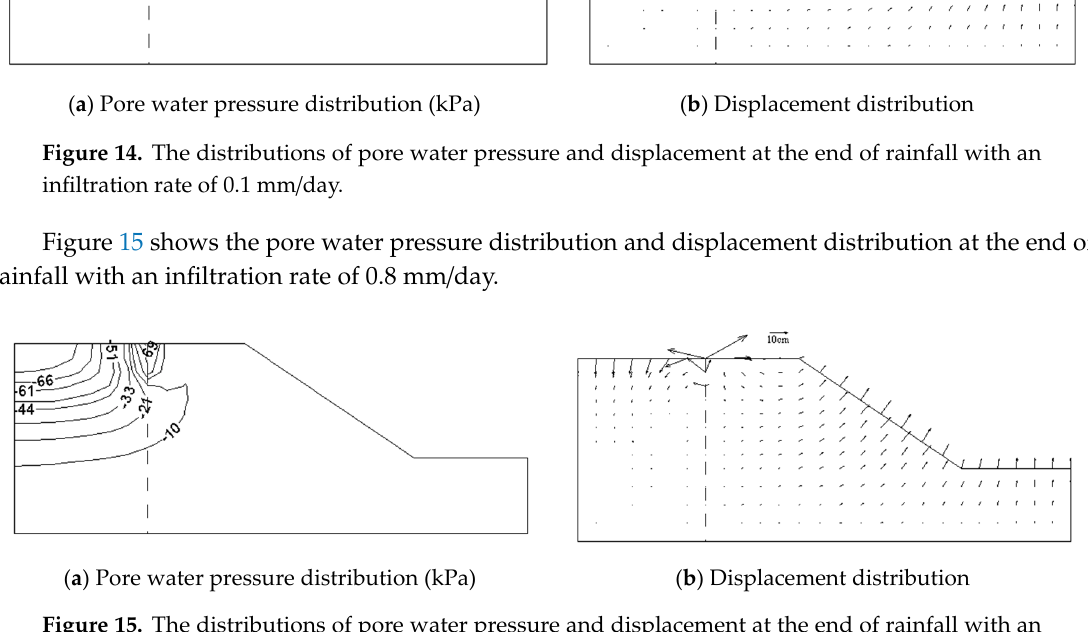
infiltration rate of 0.8 mm/day.